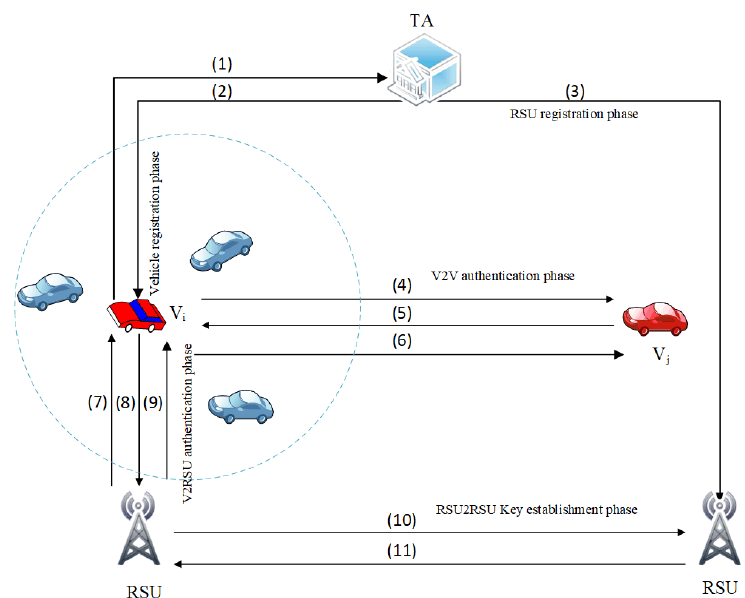
Figure 2. The phases involved in the proposed scheme. Vehicle Registration Phase (1). Registration request message (2). The registration response message. RSU Registration Phase (3). RSU’scredentials generated by TA. V2V Authentication and Key Establishment Phase (4). Authentication request message (5). Authentication reply message (6). Acknowledge message.